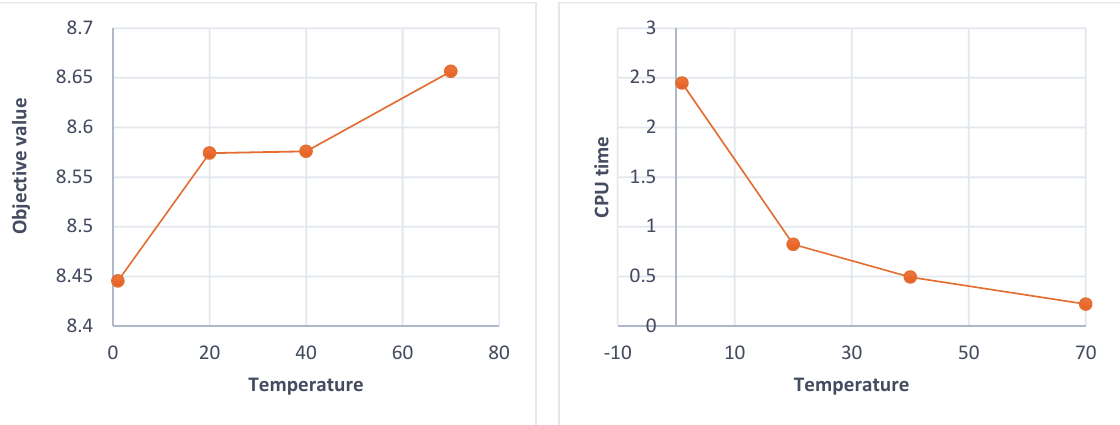
Fig. 6 . The effect of the coolest temperature on the objective value